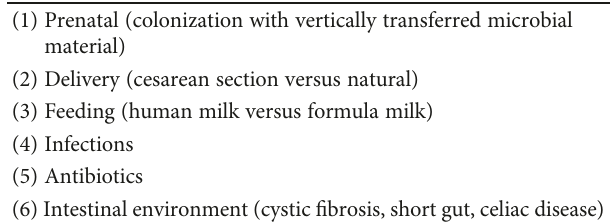
Table 1: Main factors and phases of early microbial